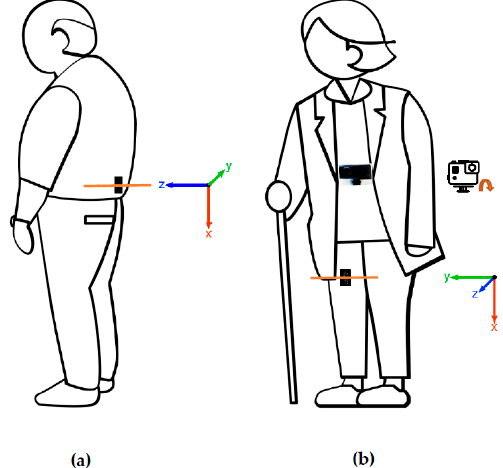
Figure 1. This figure illustrates the positions of the two accelerometers attached to the skin (high- lighted with orange lines) and the chest-mounted camera used for the HAR70+ dataset. ( a ) The back accelerometer was positioned centrally at the third lumbar vertebrae. The z -axis of the coordinate system was pointing forward. ( b ) The thigh accelerometer was positioned approximately 10 cm above the upper border of the patella. The z -axis was pointing backward. The camera was attached to the chest on the outside of the clothing, pointing